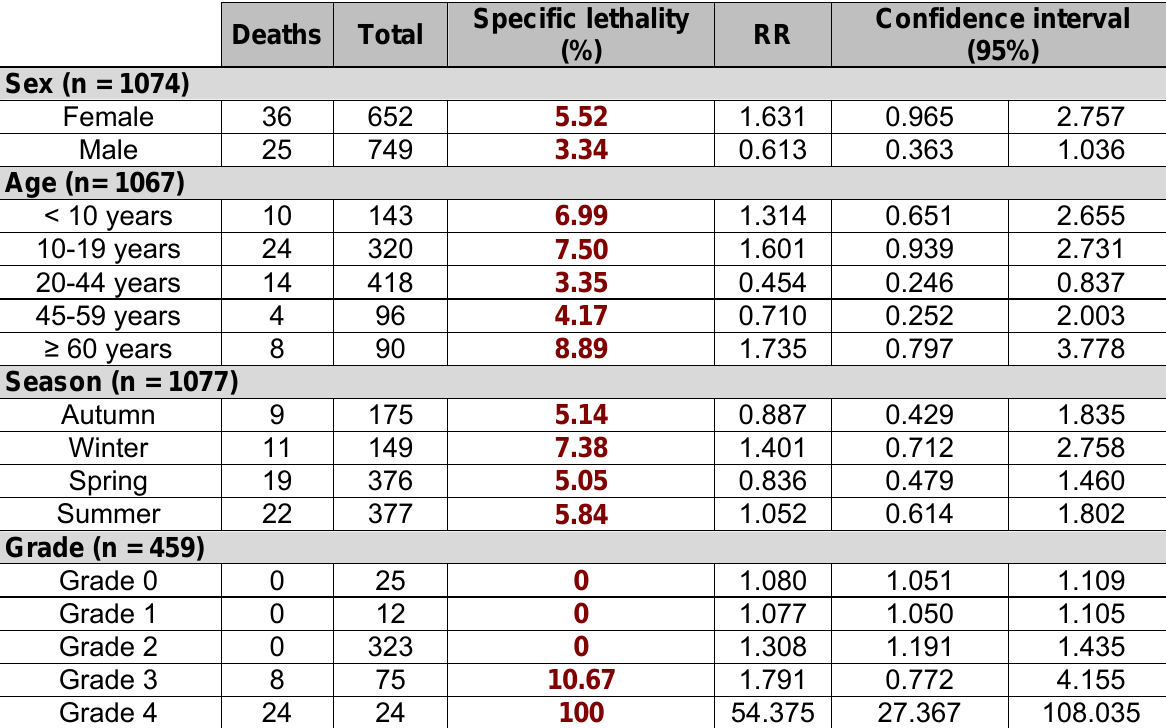
Table 1. Distribution of specific lethality and relative risk (RR) according to sex, age, season and